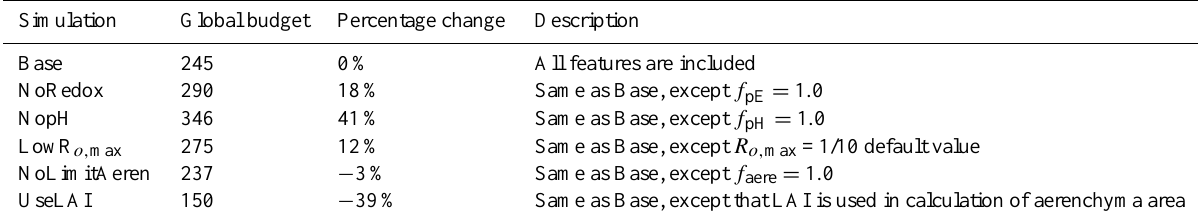
Table 7. Global methane budget for different case simulations for year 1993. Simulation Global budget Percentage change